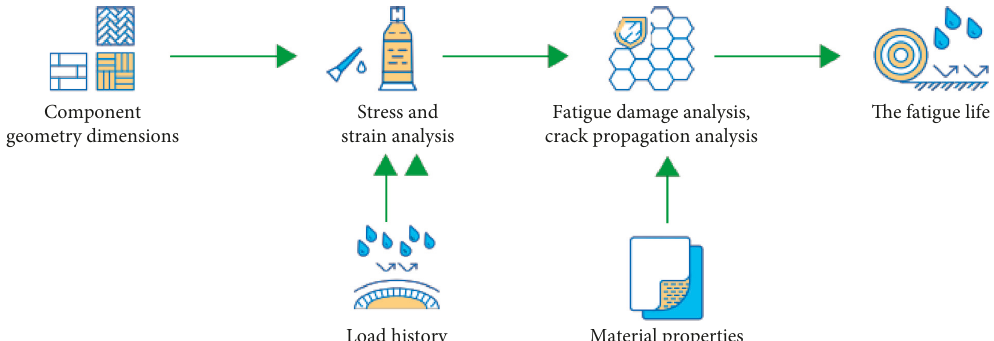
Figure 1: Wear performance analysis of fine blanking